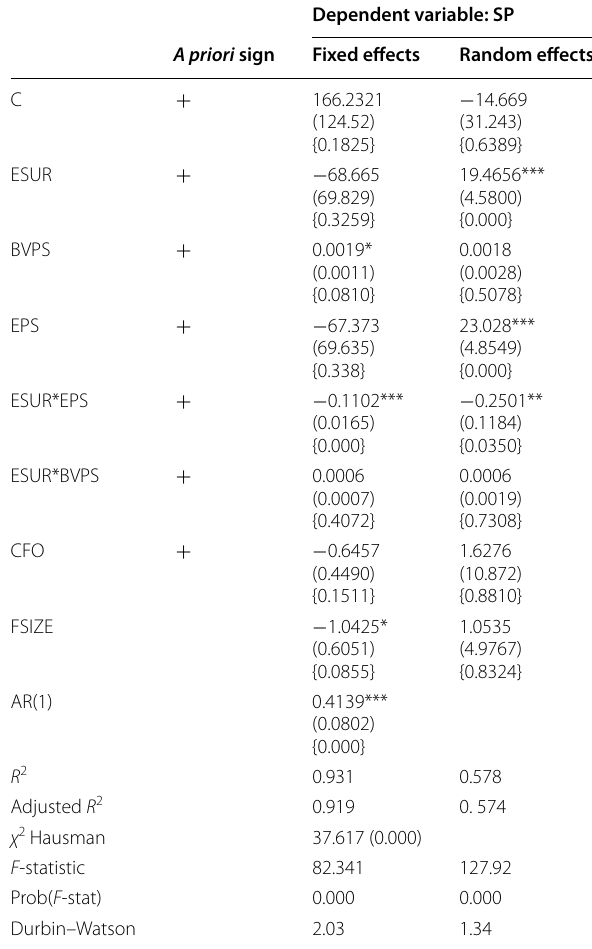
Table 6 Earnings surprise regression